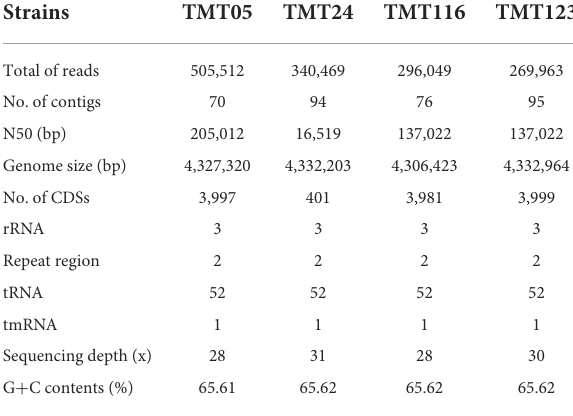
TABLE 1 Assembly and annotation of sequenced Mycobacterium tuberculosis variant bovis genomes.